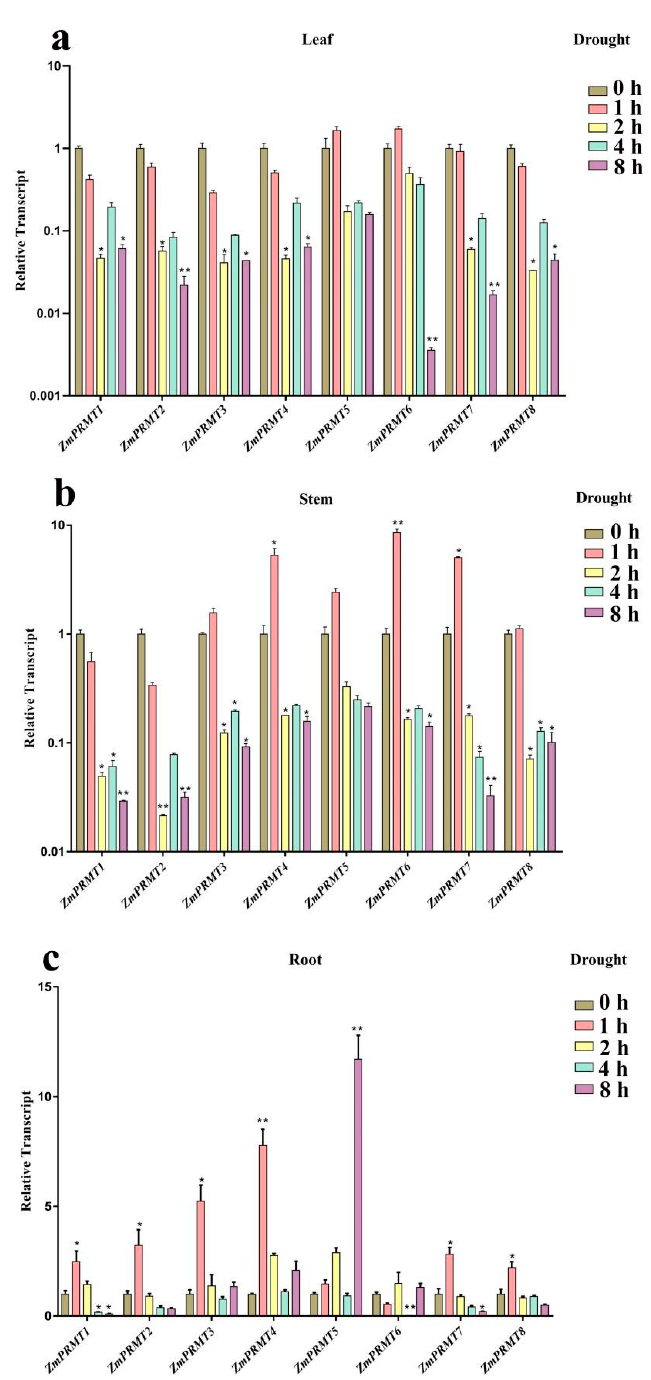
Figure 6. Expression profiling of the 8 ZmPRMT genes exposed to drought stress treatment in maize tissues (roots, stems and leaves). ( a ) The expression profiling of the 8 ZmPRMT genes exposed to drought stress treatment in maize leaves. ( b ) The expression profiling of the 8 ZmPRMT genes exposed to drought stress treatment in maize stems. ( c ) The expression profiling of the 8 ZmPRMT genes exposed to drought stress treatment in maize roots. The qRT-PCR data was standardized with the maize ZmActin1 gene. The control condition was represented as CK (0 h), and the heat stress conditions were represented as Drought (1 h, 2 h, 4 h and 8 h). X-axes represent the genes under different treatments, while the y-axes represent the scale of the relative expression level of genes. Error bar is generated by three biological repetitions. The significance level is indicated by the asterisk at the top of the error bar. p < 0.05 is significantly different *; p < 0.01 is significantly different